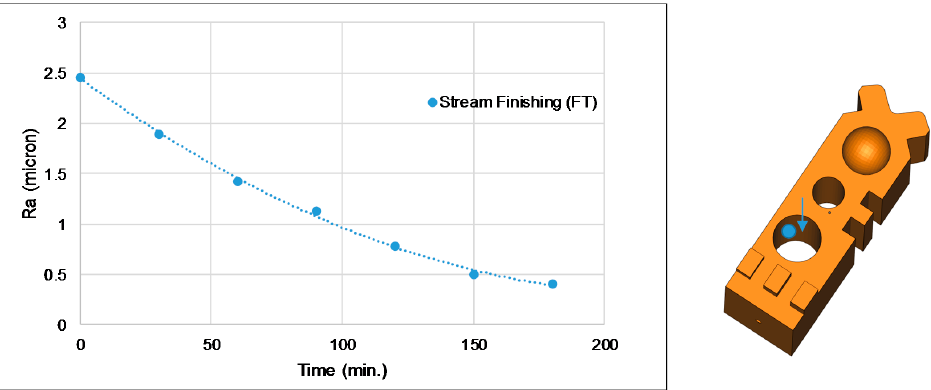
Figure 12. Stream finishing internal surface roughness values as a function of processing time (blue arrows show direction of measurement).